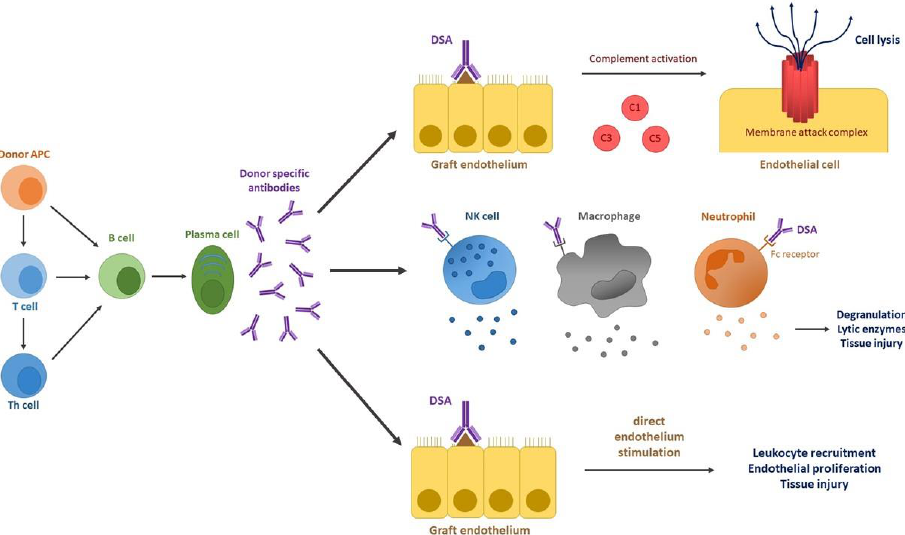
Figure 2. Donor specific antibody-related mechanism leading to graft loss in antibody-mediated rejection. DSAs lead to tissue damage through three mechanisms, dependent on and independent of complement biding. The first mechanism relies on activation of the complement classical pathway activation. Formation of the membrane attack complex (MAC) results in graft endothelial cell lysis. The second mechanism engages the innate immunity cells in antibody-dependent cellular cytotoxicity. Upon FC receptor stimulation with DSAs, NK cells, monocytes, and neutrophils release lytic enzymes, thus leading to tissue damage. In the last mechanism, direct interaction of DSAs with a graft tissue results in excessive activation of graft endothelium, leukocyte recruitment and subsequent tissue injury. APC-antigen presenting cell; Th – T helper; C1, C3, C5 – complement proteins.